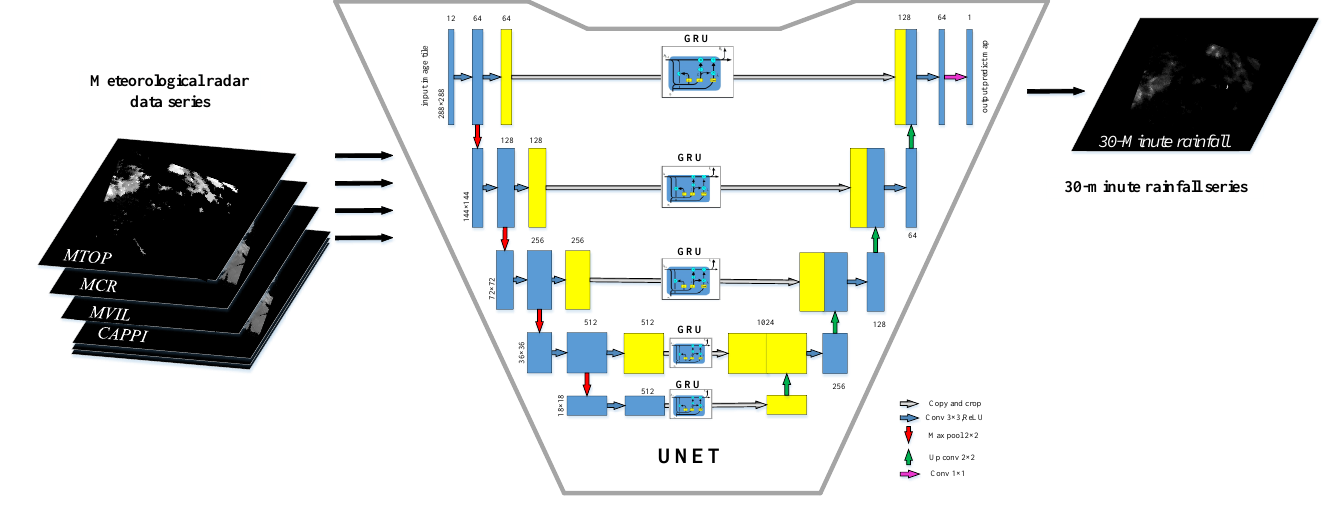
Figure 4. UNET-GRU algorithm block diagram.